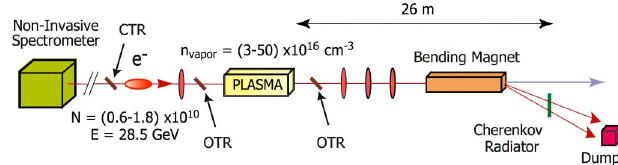
FIG. 1. (Color) Schematic of the E164 experimental layout. The diagram is not to